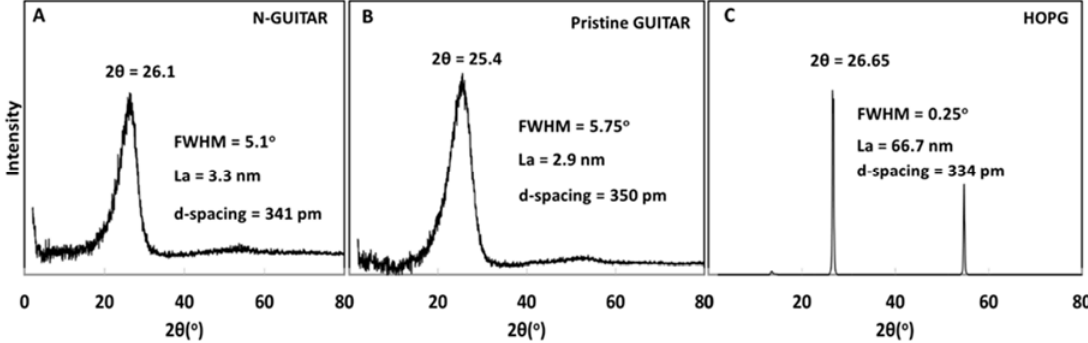
Figure 5. Powder XRD spectra of ( A ) N ‐ GUITAR, ( B ) Pristine GUITAR and ( C ) HOPG.